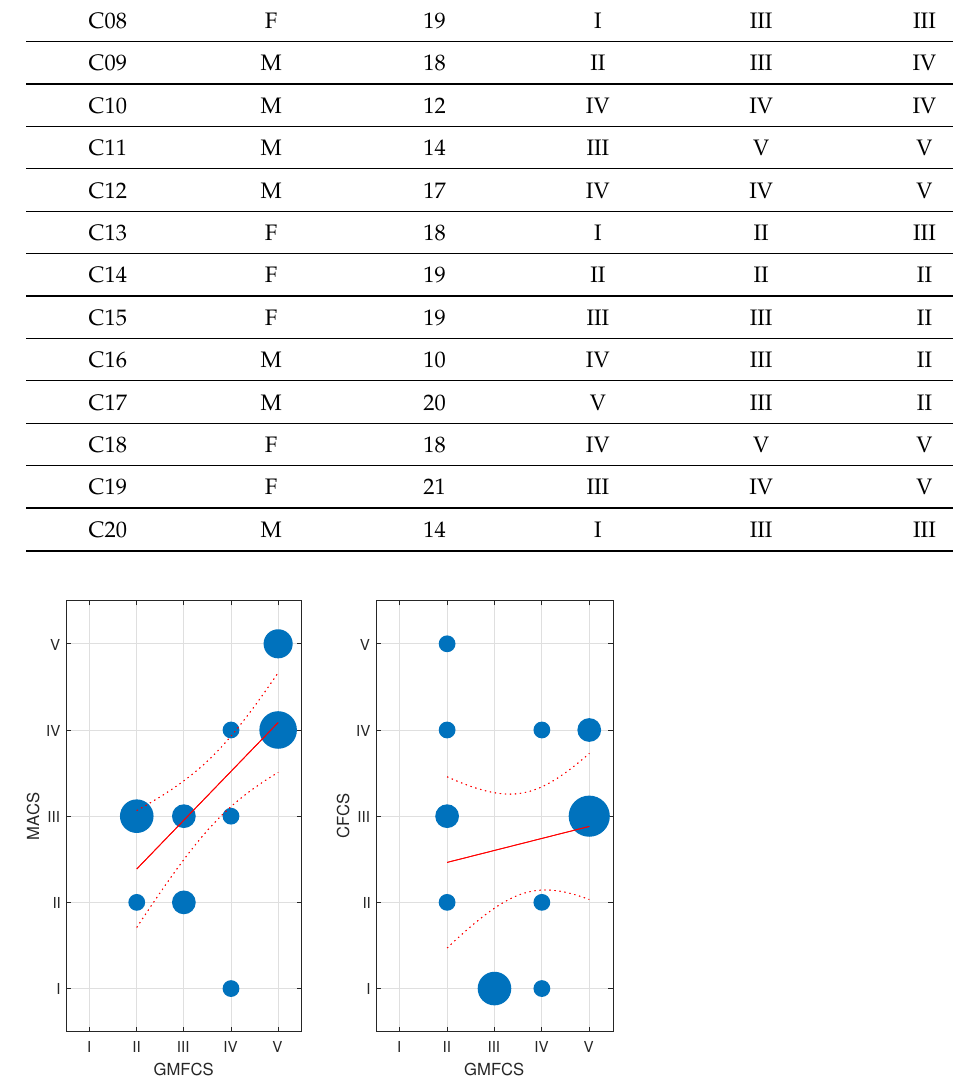
Figure 1. On the ( left ), a bubble chart comparing the GMFCS (gross motor) to MACS (fine motor) for the assessed population in CEEEMS. On the ( right ), the bubble chart comparing the GMFCS (gross motor) to CFCS (communication). The sizes of the blue circles are proportional to the number of occurrences. The linear regression (solid line) and the confidence intervals (dotted line) are also shown in